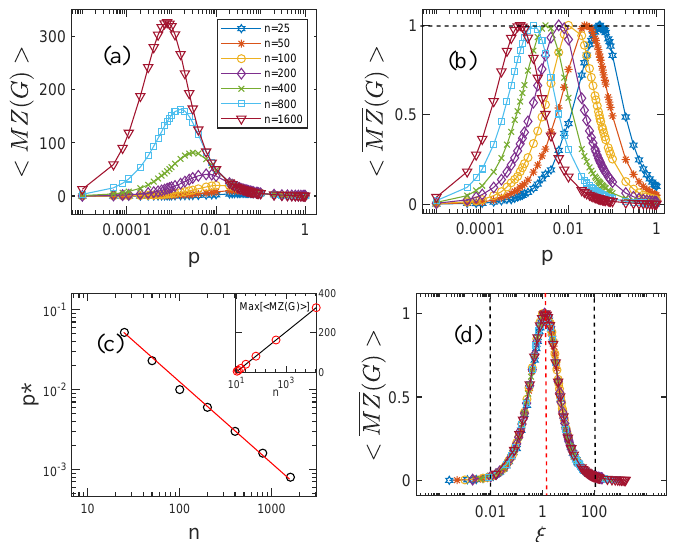
Figure 1. ( a ) Average Modified Zagreb index (cid:104) MZ ( G ) (cid:105) as a function of the probability p of Erdös − Rényi random graphs G P ( N ) of different order N ∈ [25, 1600]. ( b ) Average normalized modi- (cid:10) (cid:11) MZ ( G ) fied Zagreb index as a function of the probability p . ( c ) p ∗ as a function of n . ( d ) as a function of ξ = np